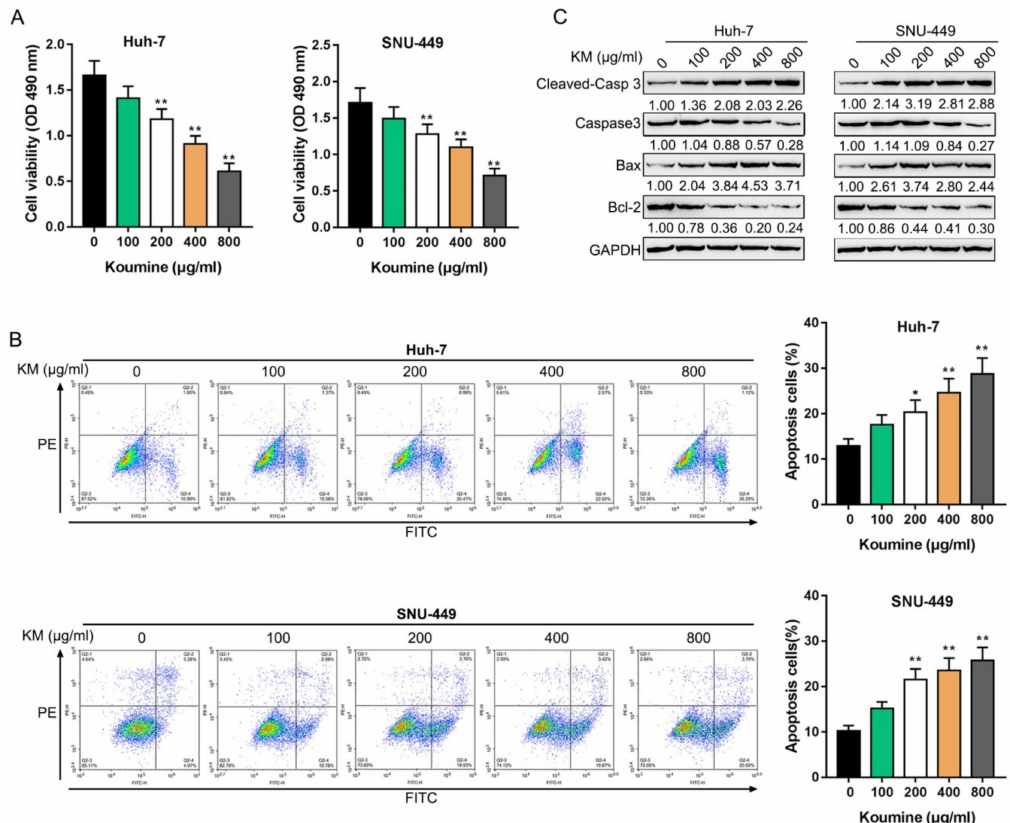
Figure 1. The killing e ff ects of koumine on hepatocellular carcinoma (HCC) cells. HCC cells were treated with 0, 100, 200, 400, and 800 µ g / mL koumine and examined for ( A ) cell viability by MTT assays; ( B ) cell apoptosis by flow cytometry; ( C ) protein levels of apoptosis-related factors, including cleaved-Caspase3, Caspase3, Bax, and Bcl-2. * p < 0.05, ** p <